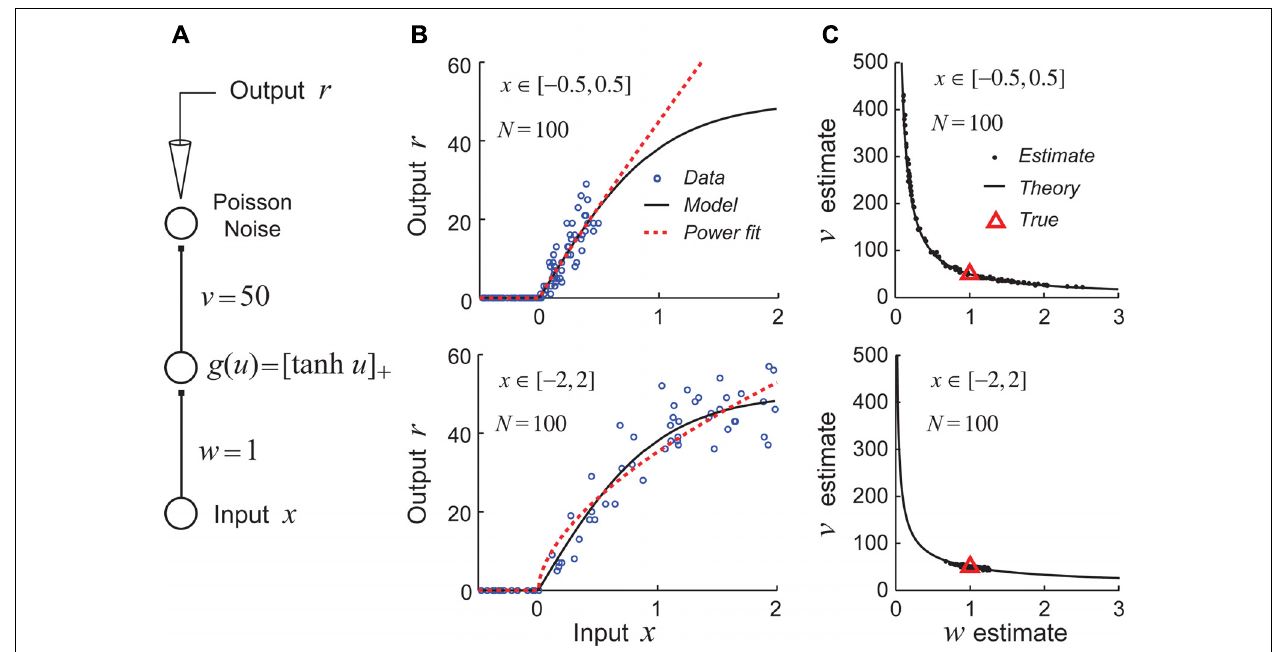
power law function (red dashed line). Bottom :The input stimuli x ∈ [ − 2,2] drive the hidden unit over a larger region of its gain function which is poorly approximated by a power law function. (C) Top :When trained with sets of stimuli like that in the top of Figure 4B , the estimates (black dots) lie scattered along the curve predicted by the power law confounding theory. Bottom : When trained with sets of stimuli like those in the bottom panel of Figure 4B , the true parameter values (red triangle) are more reliably